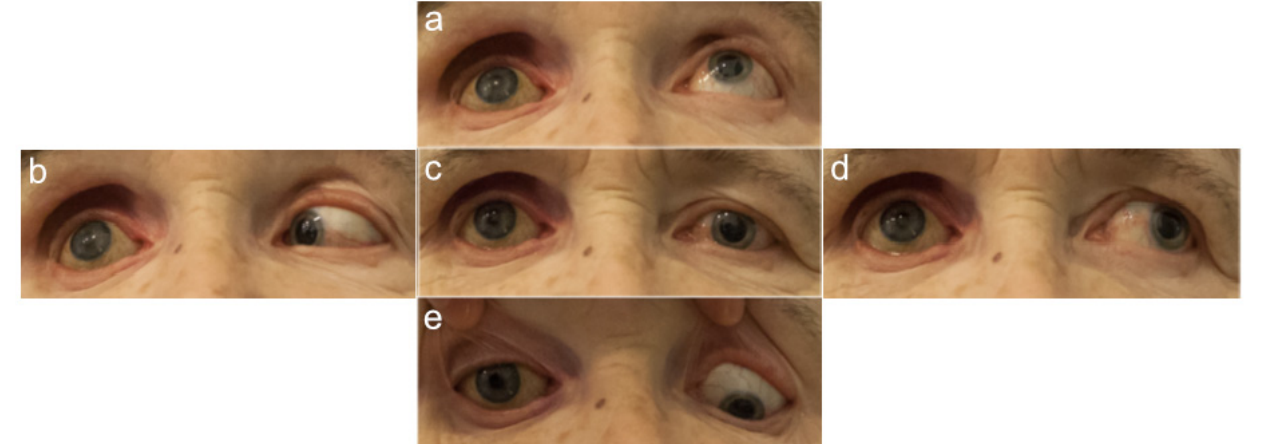
Figure 4. Photographs of a patient without an orbital implant, with a glass prosthetic eye on the right. Five cardinal directions of gaze: ( a ) up, ( b ) to the right, ( c ) straight ahead, ( d ) to the left, and ( e ) down. Source: Division of Ophthalmology and Ocular Oncology, Jagiellonian University Medical College; own material.